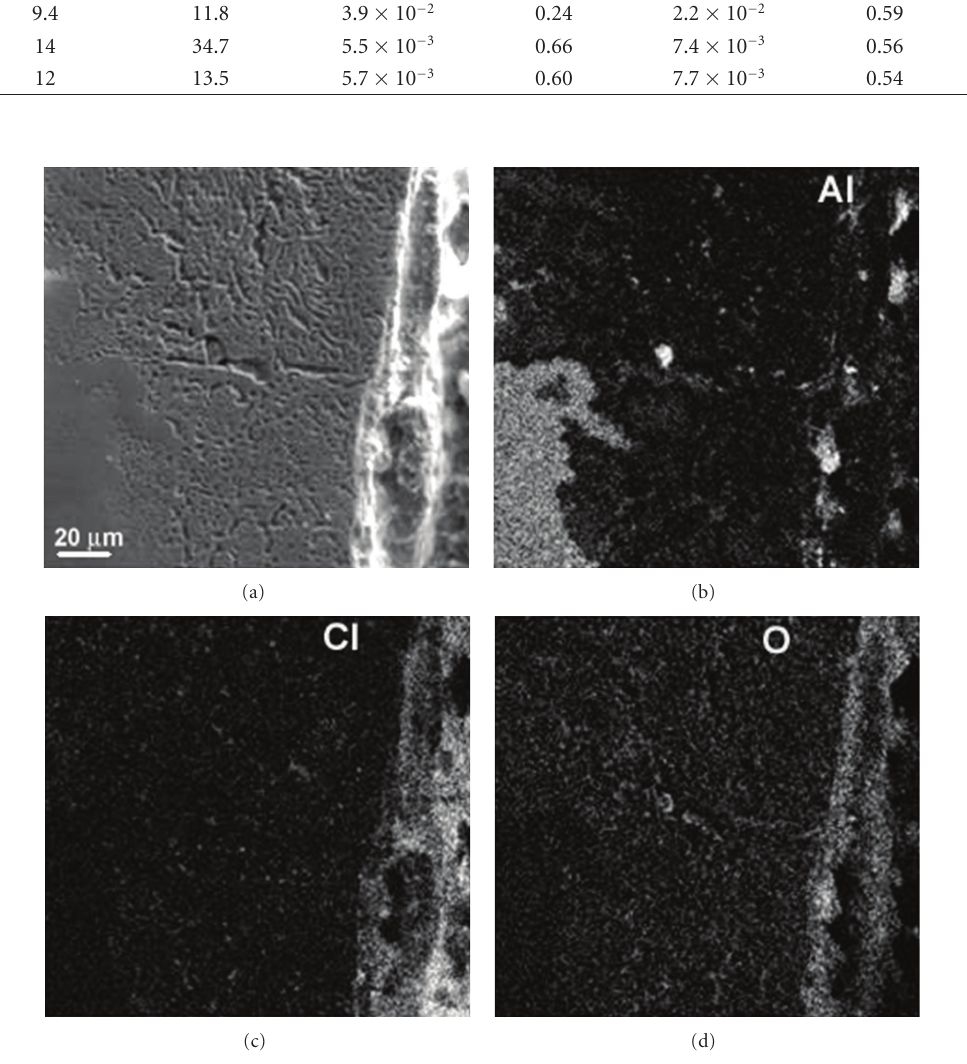
Figure 9: Microphotograph of Fe40Al corroded in the KCl + ZnCl 2 mixture at 670 ◦ C together with X-ray mappings of Al, Cl, and